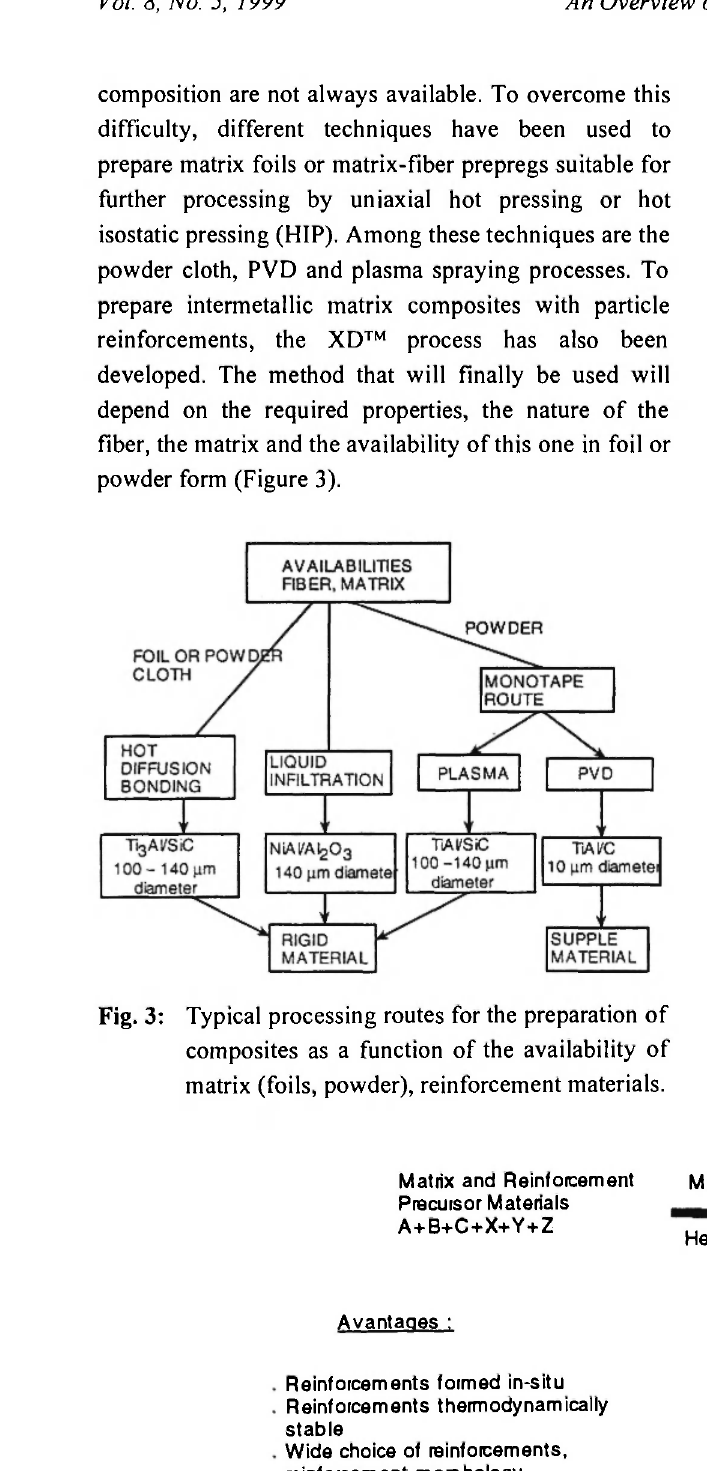
Fig. 3: Typical processing routes for the preparation of composites as a function of the availability of matrix (foils, powder), reinforcement materials.